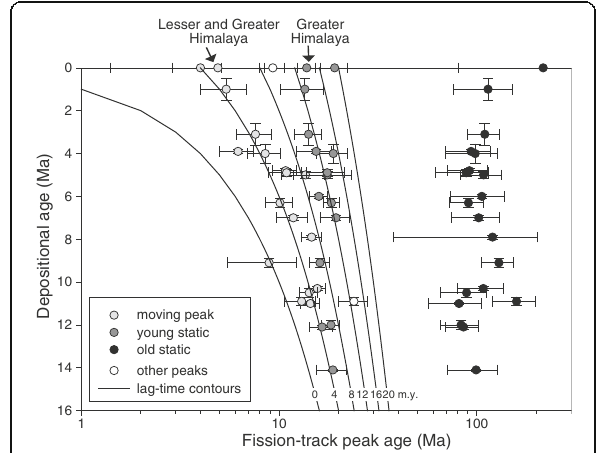
Fig. 10 Lag time plot of detrital zircon fission track peak ages versus depositional ages of Siwalik Group sedimentary rocks from Nepal and modern river sediment from Bernet et al. (2006). Peak ages are given with two σ errors. Old static peak refers to fission track age populations ~ 100 Ma and that do not change up-section. Young static peak refers to fission track age populations ~ 20 Ma and that do not change up-section. The young moving peak of fission track ages that appears after 11 Ma maintains a constant lag time of ~ 4 m.y. but constitutes a smaller fraction of the total sediment